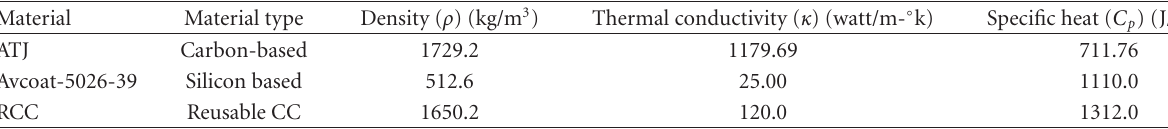
Table 11: Material and thermal properties of carbon and silicon-based ablators.